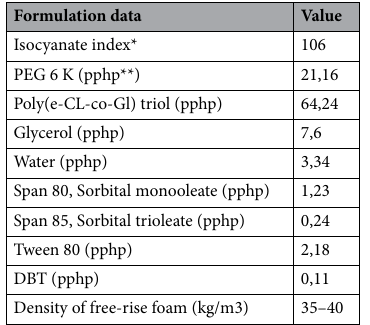
Table 3. The PUEt formulations data. All the 3 formulations: PUEt 4:1; PUEt 10:1; PUEt 20:1, were synthetized according to the same experimental condition except for the CL:GL ratio in each polyester, as described in Table 2 and Fig. 1A. *((eq NCO)/(eq OH)∙100); ** = pphp, parts per hundred